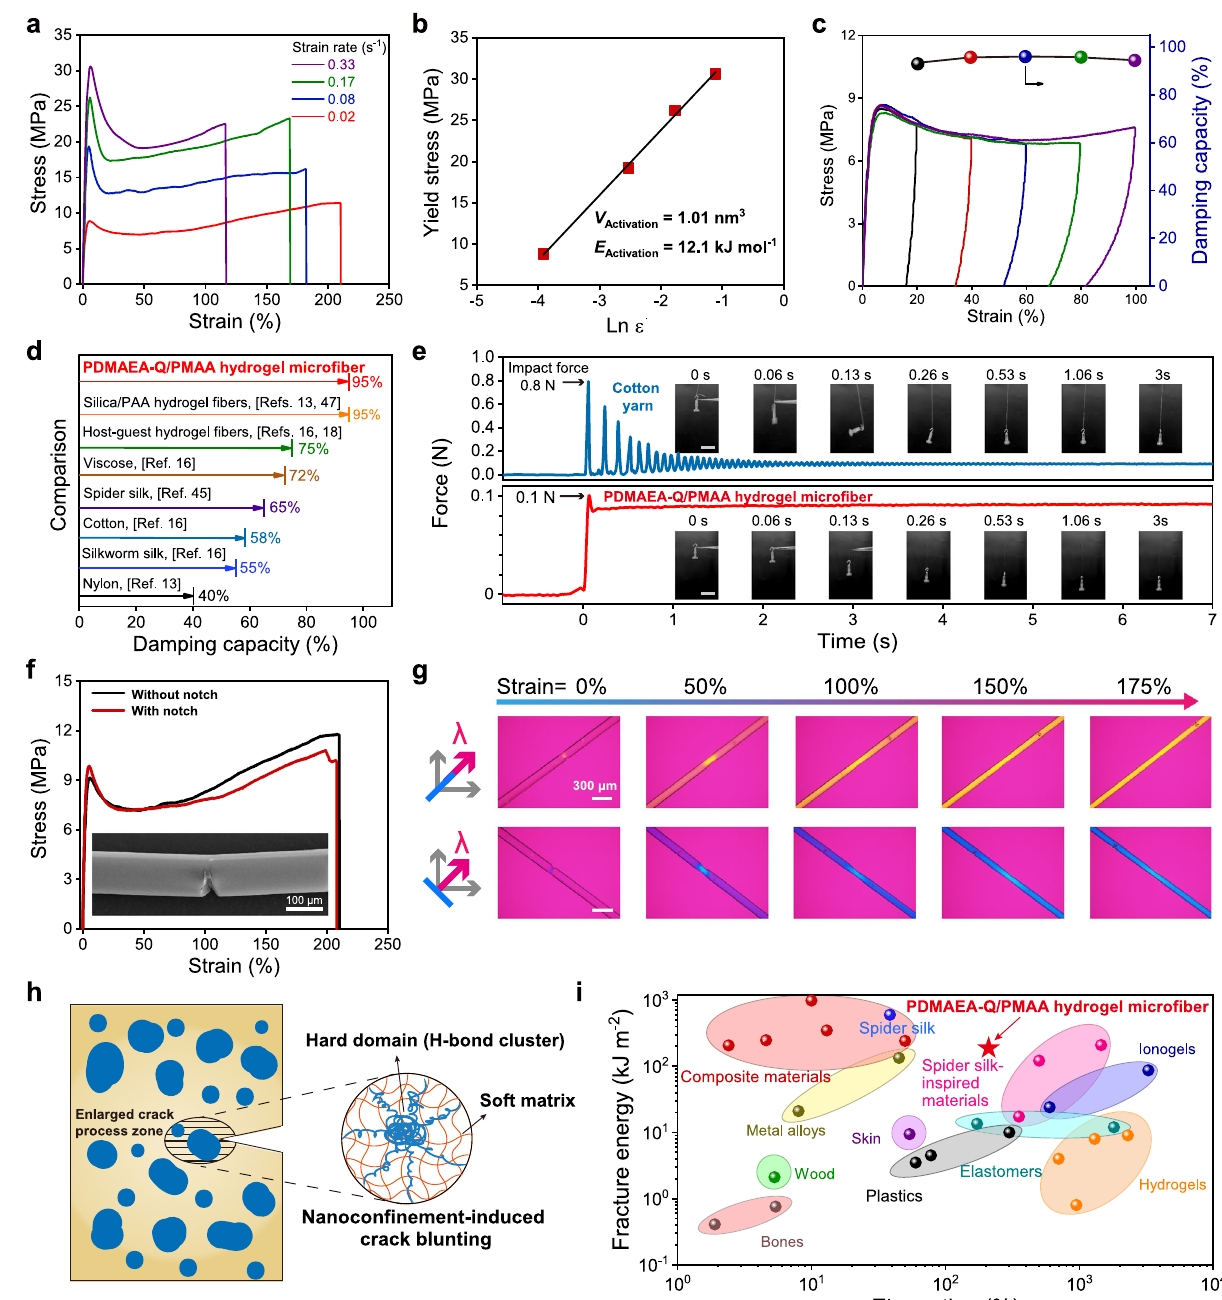
Fig. 3 | Tensile, damping, and crack-resistant properties of PDMAEA-Q/PMAA hydrogelmicro fi ber.a Tensilebehavioratdifferentstrainrates(RH60%). b Linear fi tting of yield stresses as a function of the natural logarithm of strain rates ( ε ̇ ). c Cyclic loading-unloading curves and corresponding damping capacities with increasing strains (strain rate = 0.02s − 1 ). d Comparison of the damping capacity of thehydrogelmicro fi berwithothertypicaldamping fi bermaterials. e Time-resolved impact force oscillations of a free-falling object buffered by cotton yarn and the